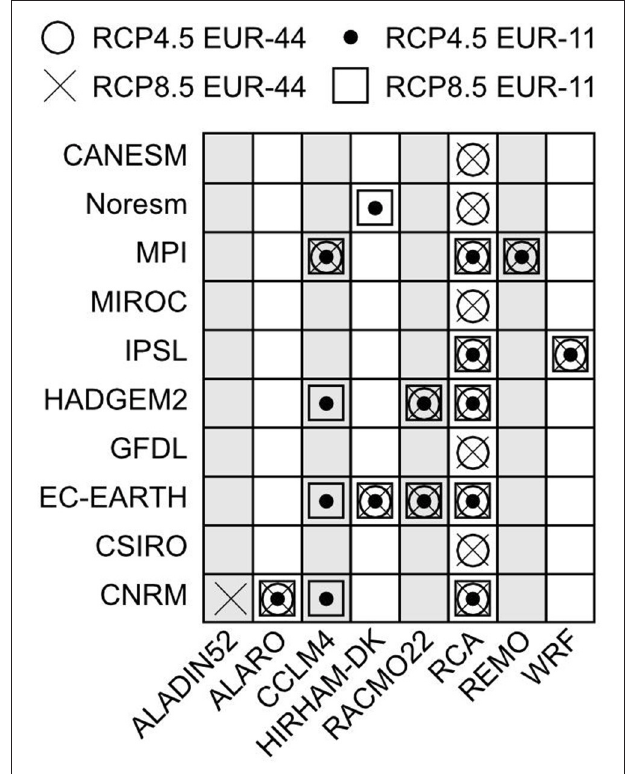
FIGURE 1 | GCM/RCM matrix for the EURO-CORDEX experiments used in this